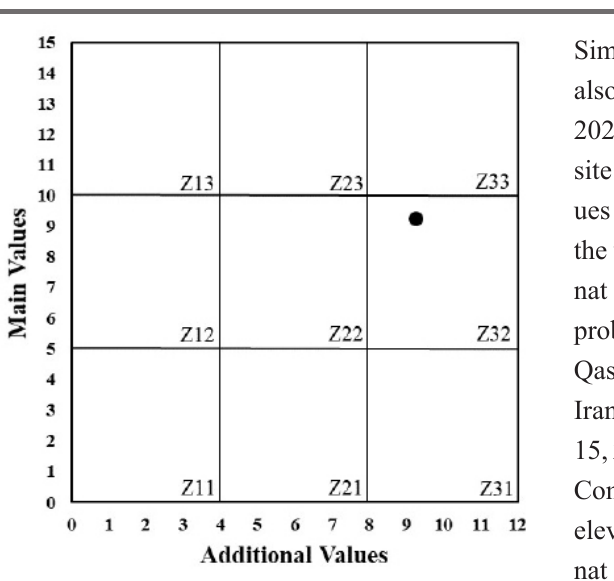
Figure 4. According to the GAM analysis, Gonabad Qasabeh qanat plots in the Z32